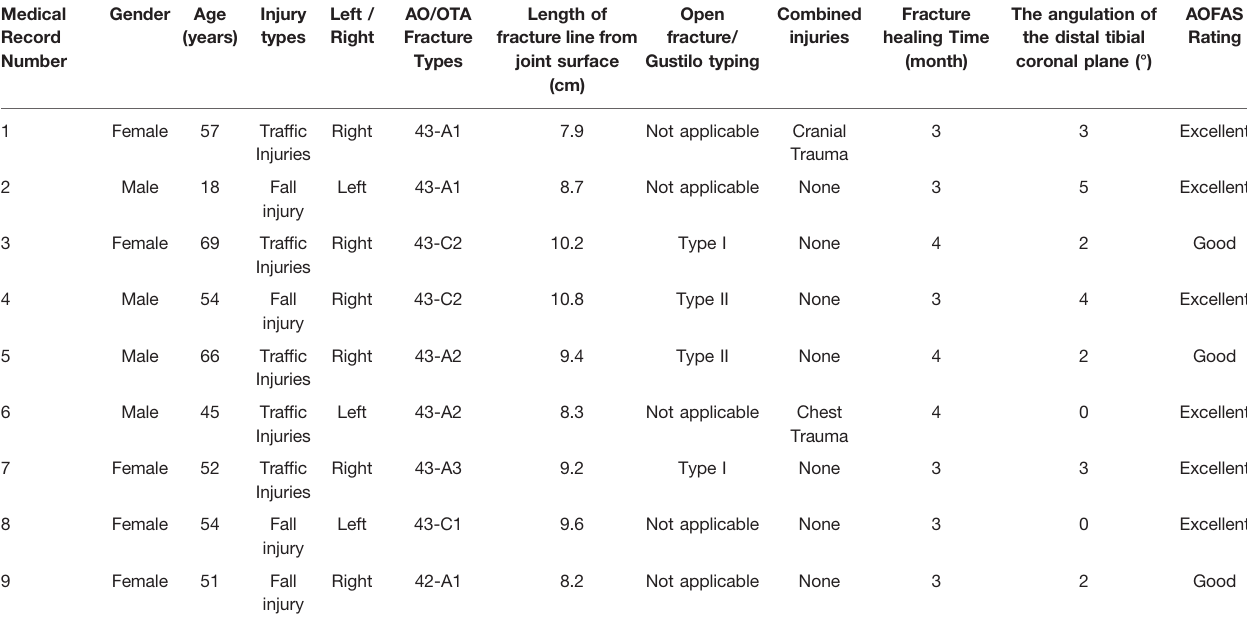
TABLE 1 | Patient data for closed reduction of distal tibial fracture with new retrograde tibial intramedullary nail internal fi xation. Medical Gender Age Injury Left / AO/OTA Record (years) types Right Fracture Number